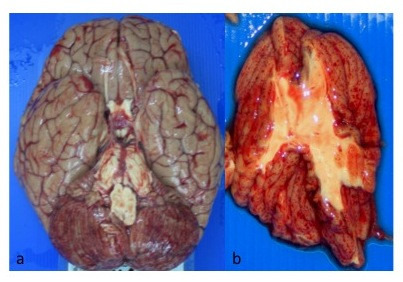
Gross appearance of the brain. The outer surface appears dusky with petechial haemorrhages seen on the outer surface of the cerebellum (2a). Cut section of the cerebellum with multiple petechial haemorrhages seen within the cerebellar grey matter (2b).